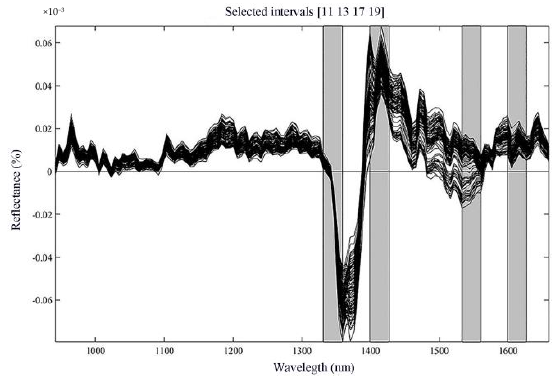
Figure 4. Feature extraction processing of the synergy interval partial least squares for the matrix available nitrogen content spectra.